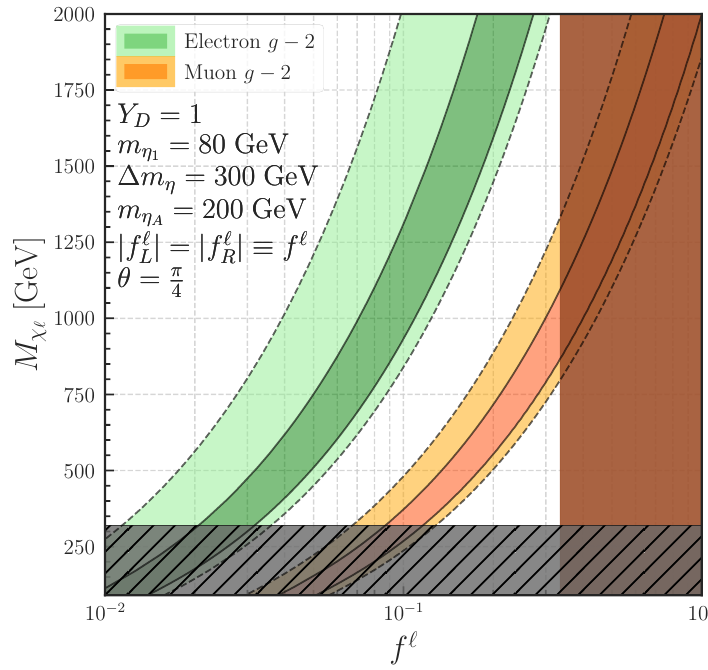
Figure 10 . Summary of the constraints in the plane of f ‘ and M Y D = 1 and ( m (cid:17) ; m (cid:17) ; m (cid:17) ; m ; (cid:18) ) = (80 GeV ; 380 GeV ; 200 GeV ; 200 GeV ; (cid:25)= 4). The regions (cid:17) (cid:6) 1 2 A shaded by dark green and orange can explain the electron and the muon g lower bounds on M (cid:31) are derived from the direct search limit by the ATLAS collaboration, while ‘ the brown area cannot explain the observed DM relic